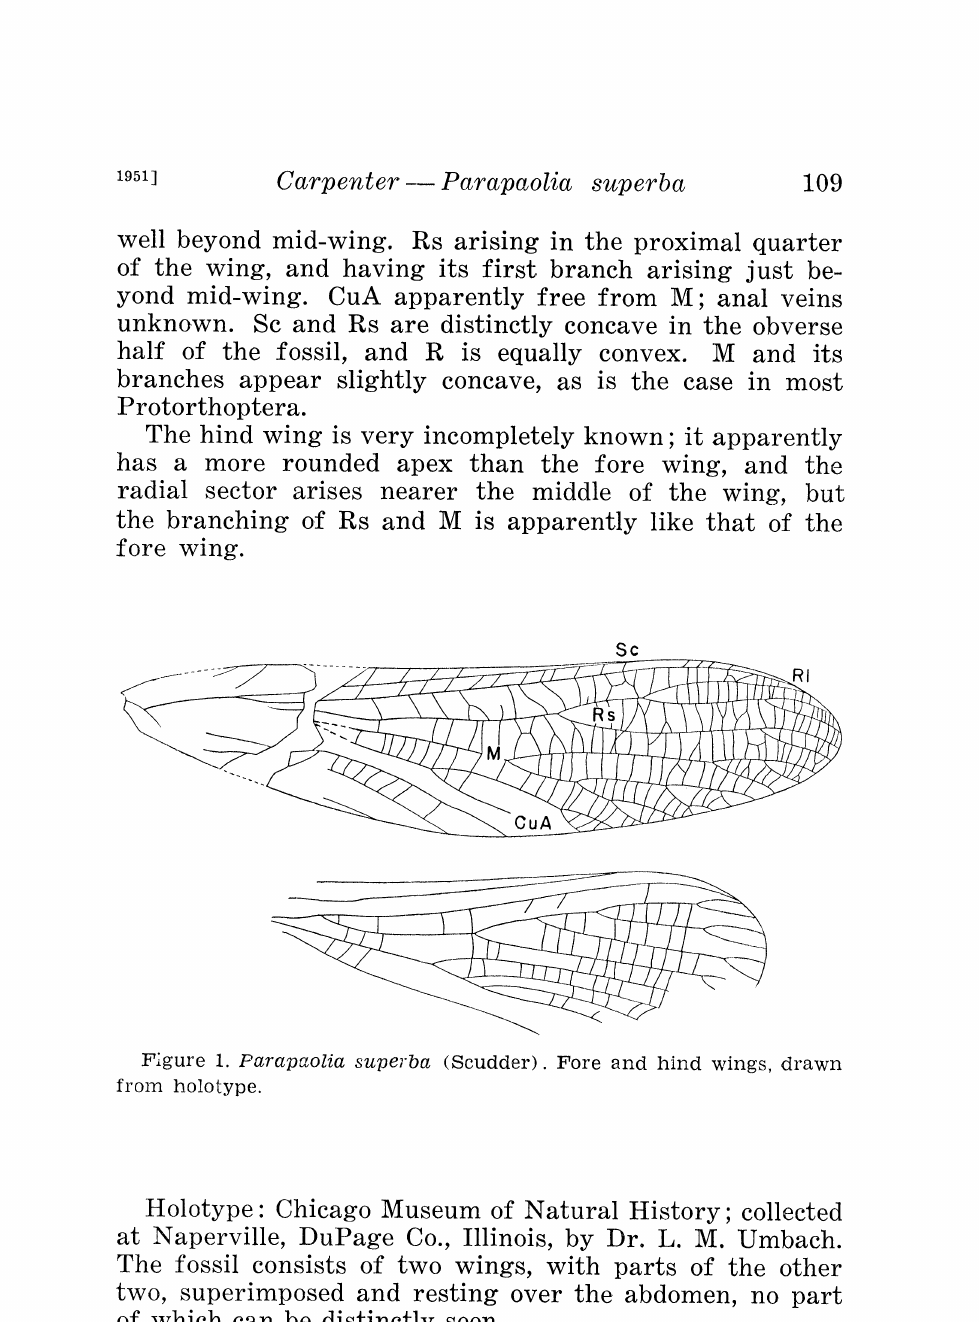
Figure 1. Parapaolia supe’ba (Scudder). Fore and hind wings, drawn from